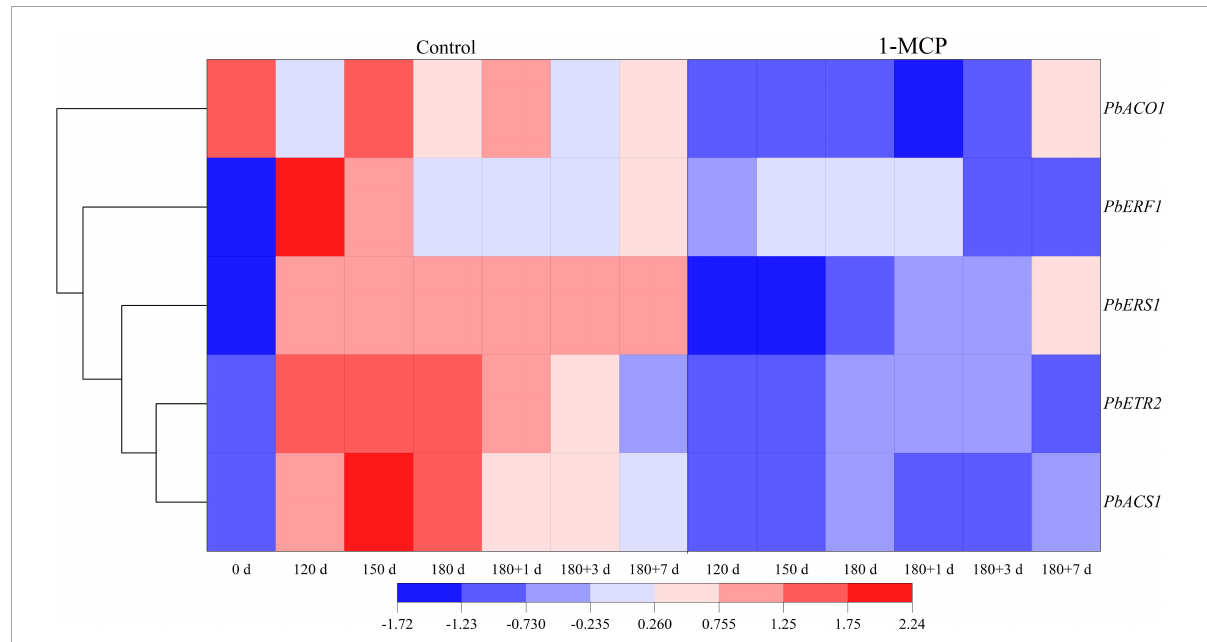
FIGURE3 Effect of 1-MCP on the expression of ethylene synthesis genes ( PbACS1 , PbACO1 ), receptor genes ( PbETR2 , PbERS1 ), and ethylene response factor genes ( PbERF1 ) of the peels in “Yali” pear during cold storage and shelf life. 180 + 1, 180 + 3, 180 + 7 indicated Days 1, 3, 7 at shelf life after 180 days of cold storage,